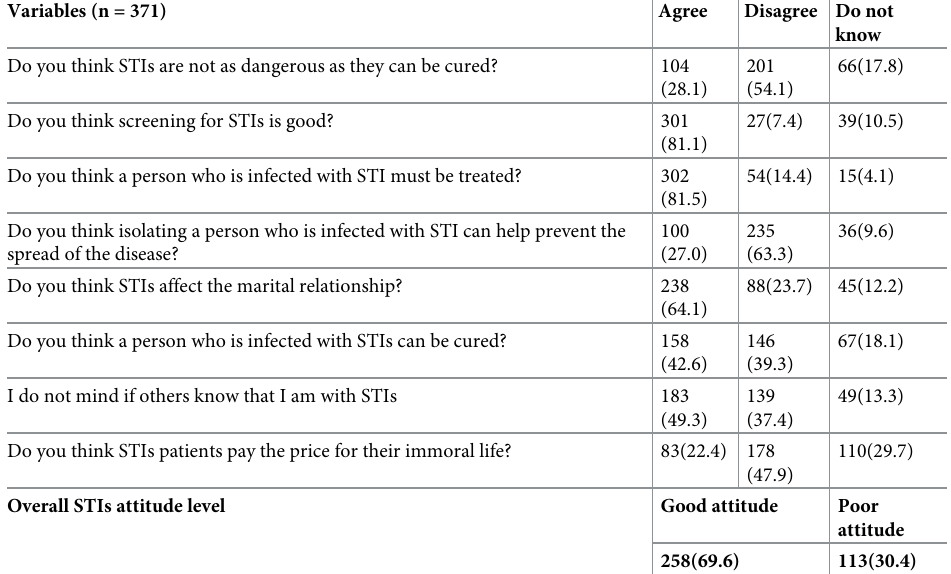
Table 6. The respondents’ attitude towards STIs in North-shewa zone, Ethiopia, 2019.